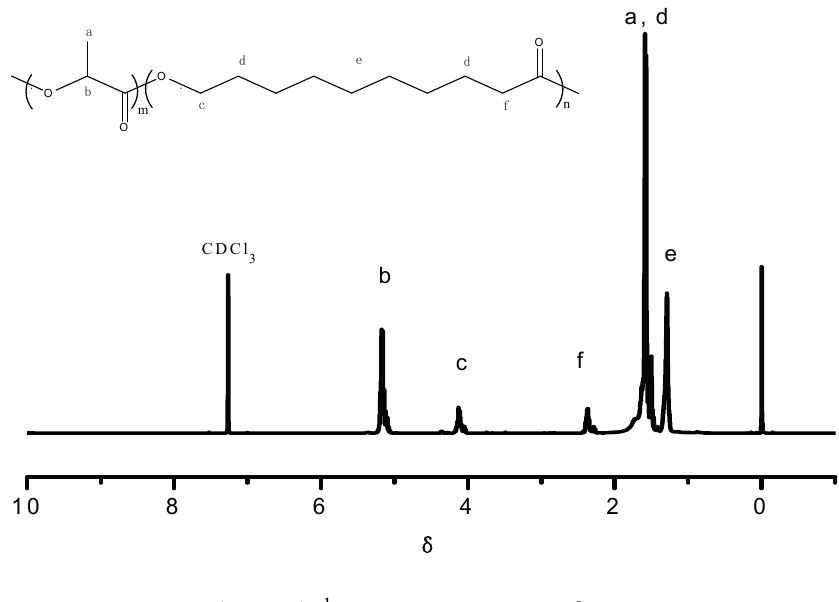
Figure 1. 1 H NMR spectrum of PLH. Table 1. Compositions and molecular weights of the PLH copolymers, PLA and PHDA homopolymers. PDI , polydispersity. PLH9.3, PLH composition with molar ratios of LA to HDA of